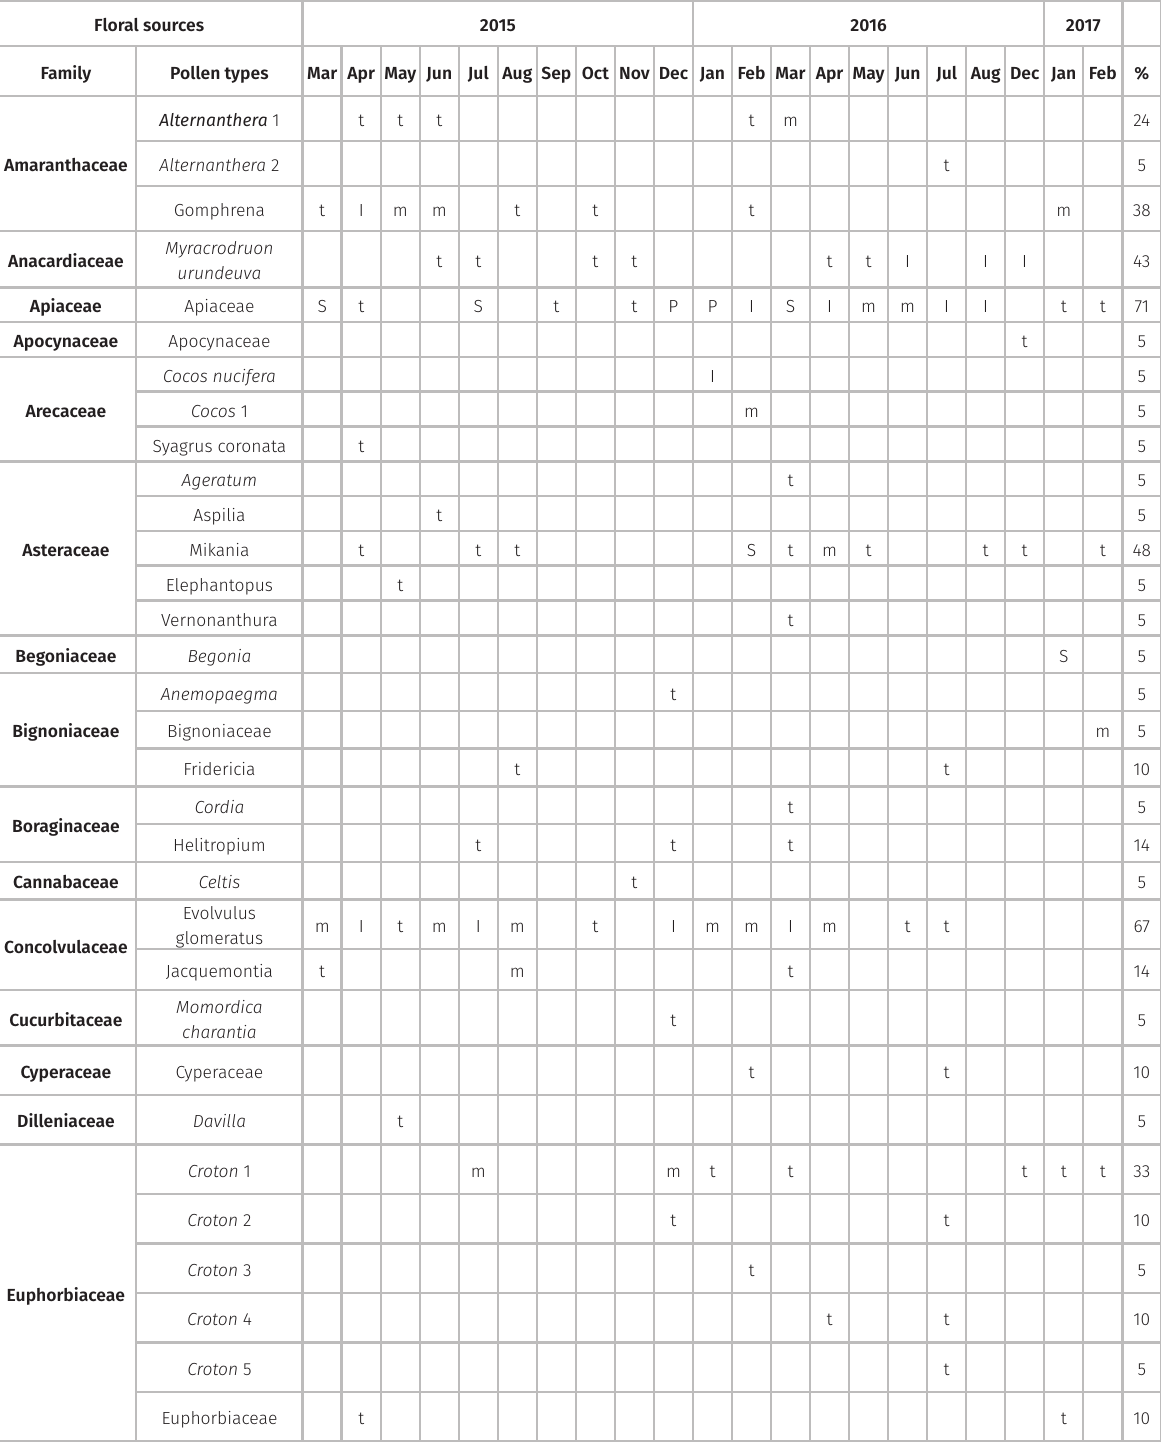
Table III. Pollen types from honey of Apis mellifera L. produced over two years in the study area. Frequency Classes: P = predominant pollen, S = secondary pollen, I = important minor pollen, m = minor pollen, t = trace pollen, % = frequency between